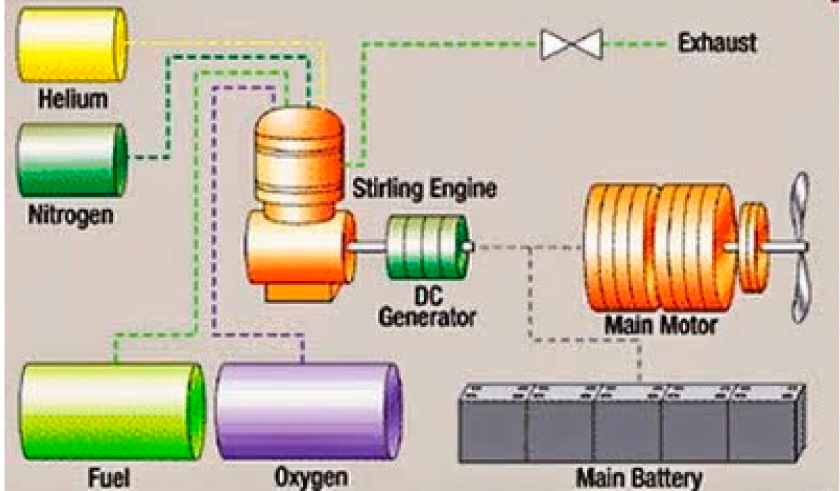
Figure 14. Stirling Engine AIP Configuration [75].